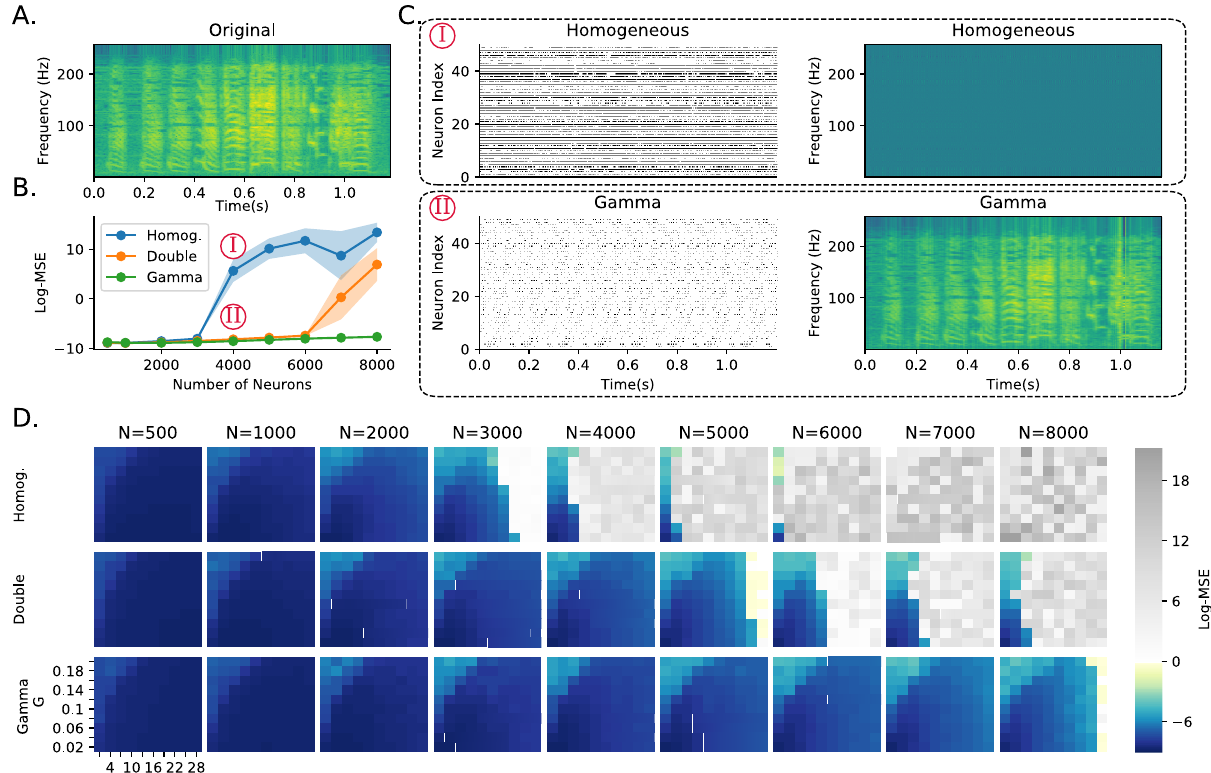
Fig. 3 Robustness to learning hyperparameter mistuning. A Spectrogram of a zebra fi nch call. The network has to learn to reproduce this spectrogram, chosen for its spectrotemporal complexity. B Error for three networks at different network sizes (hyperparameters G and Q were chosen to optimise performance at N = 1000 neurons as given in Table 4). Networks are fully homogeneous (Homog); intermediate, where each neuron is randomly assigned slow or fast dynamics (Double); or fully heterogeneous, where each neuron has a random time constant drawn from a gamma distribution (Gamma). C Raster plots of 50 neurons randomly chosen, and reconstructed spectrograms under fully homogeneous and fully heterogeneous (Gamma) conditions for N = 4000 neurons as indicated in B . D Reconstruction error. Each row is one of the three con fi gurations shown as lines in B . Each column is a network size. The axes of each image give the learning hyperparameters ( G and Q ). Grey pixels correspond to log mean square error above 0, corresponding to a complete failure to reconstruct the spectrogram. The larger the coloured region, the more robust the network is, and less tuning is